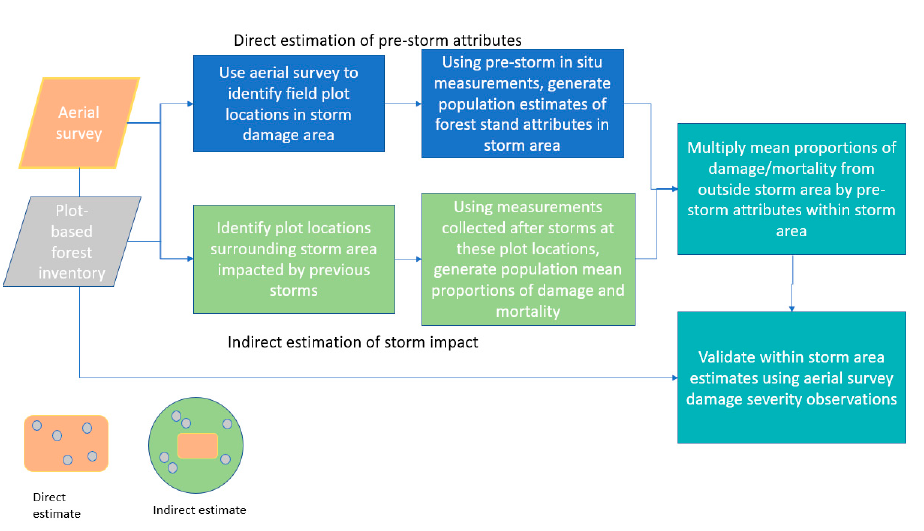
Figure 3. Flowchart overview of methodology.